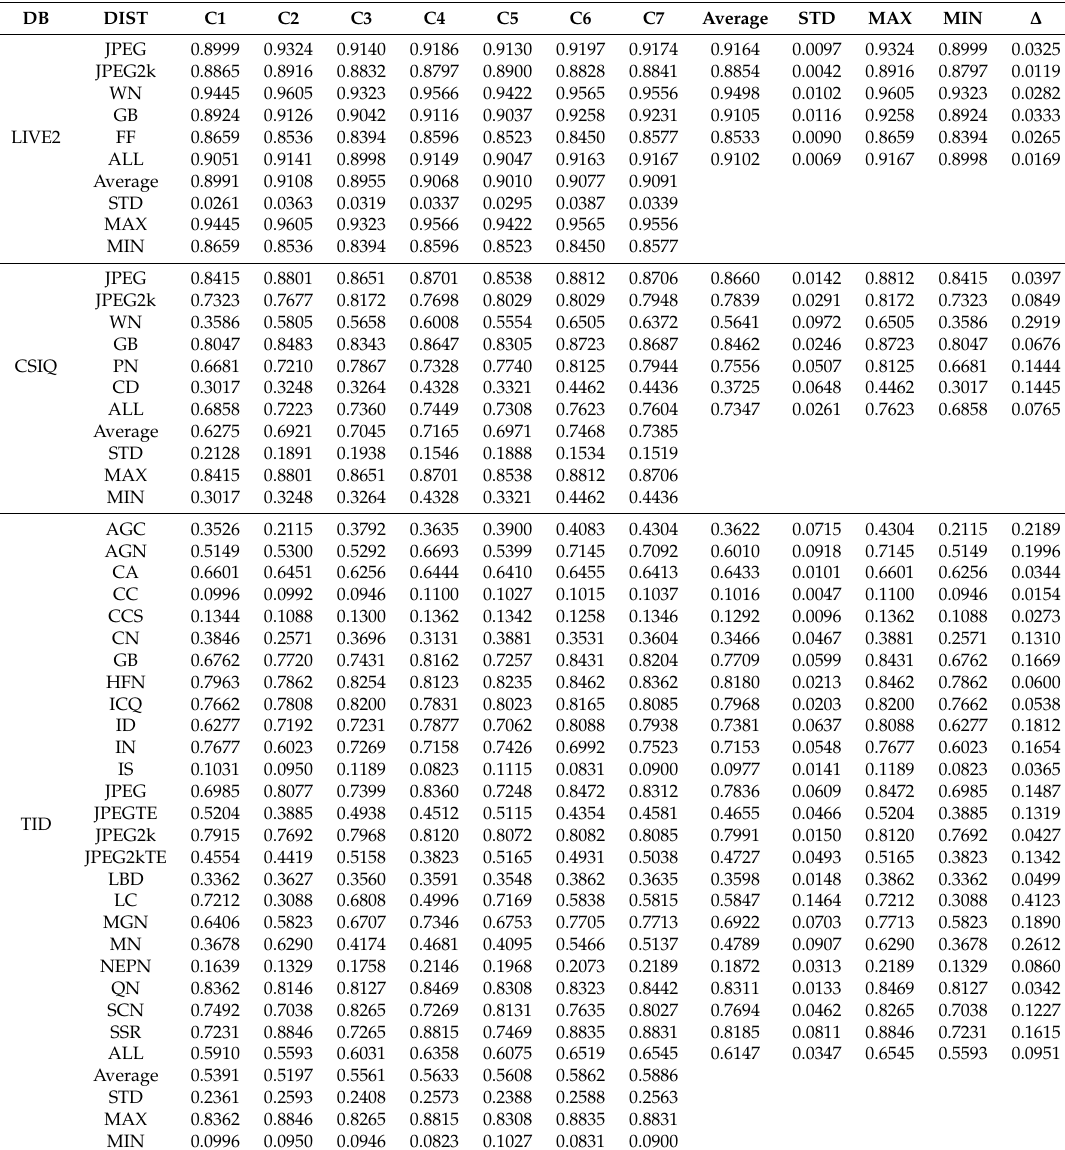
Table 4. Average SROCC of 1000 runs of simulations on tested databases using LPQ